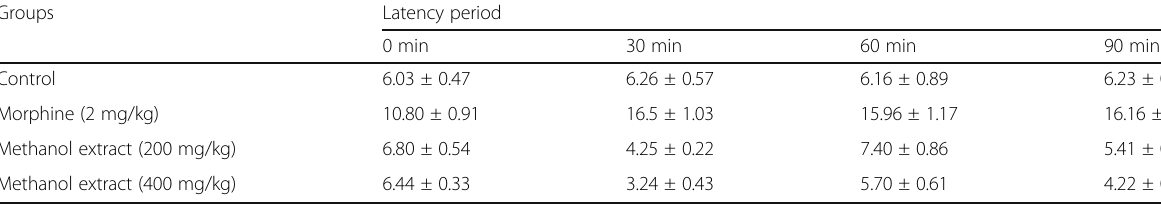
Table 5 Effect of L. speciosa flower extract on tail flicking time of mice